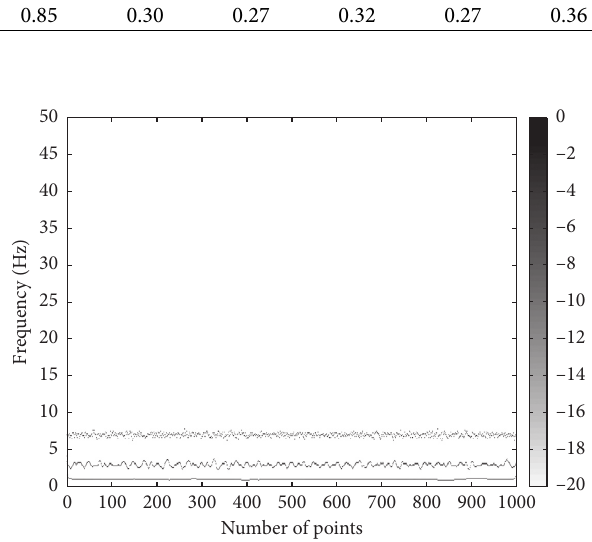
Figure 9: Hilbert–Huang plot (improved